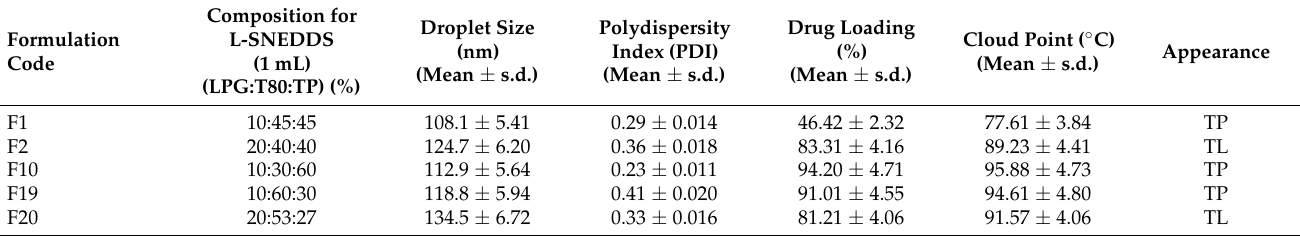
Table 2. Evaluation parameters (n = 5) and composition of selected batches of XH loaded L-SNEDDS (% w/w